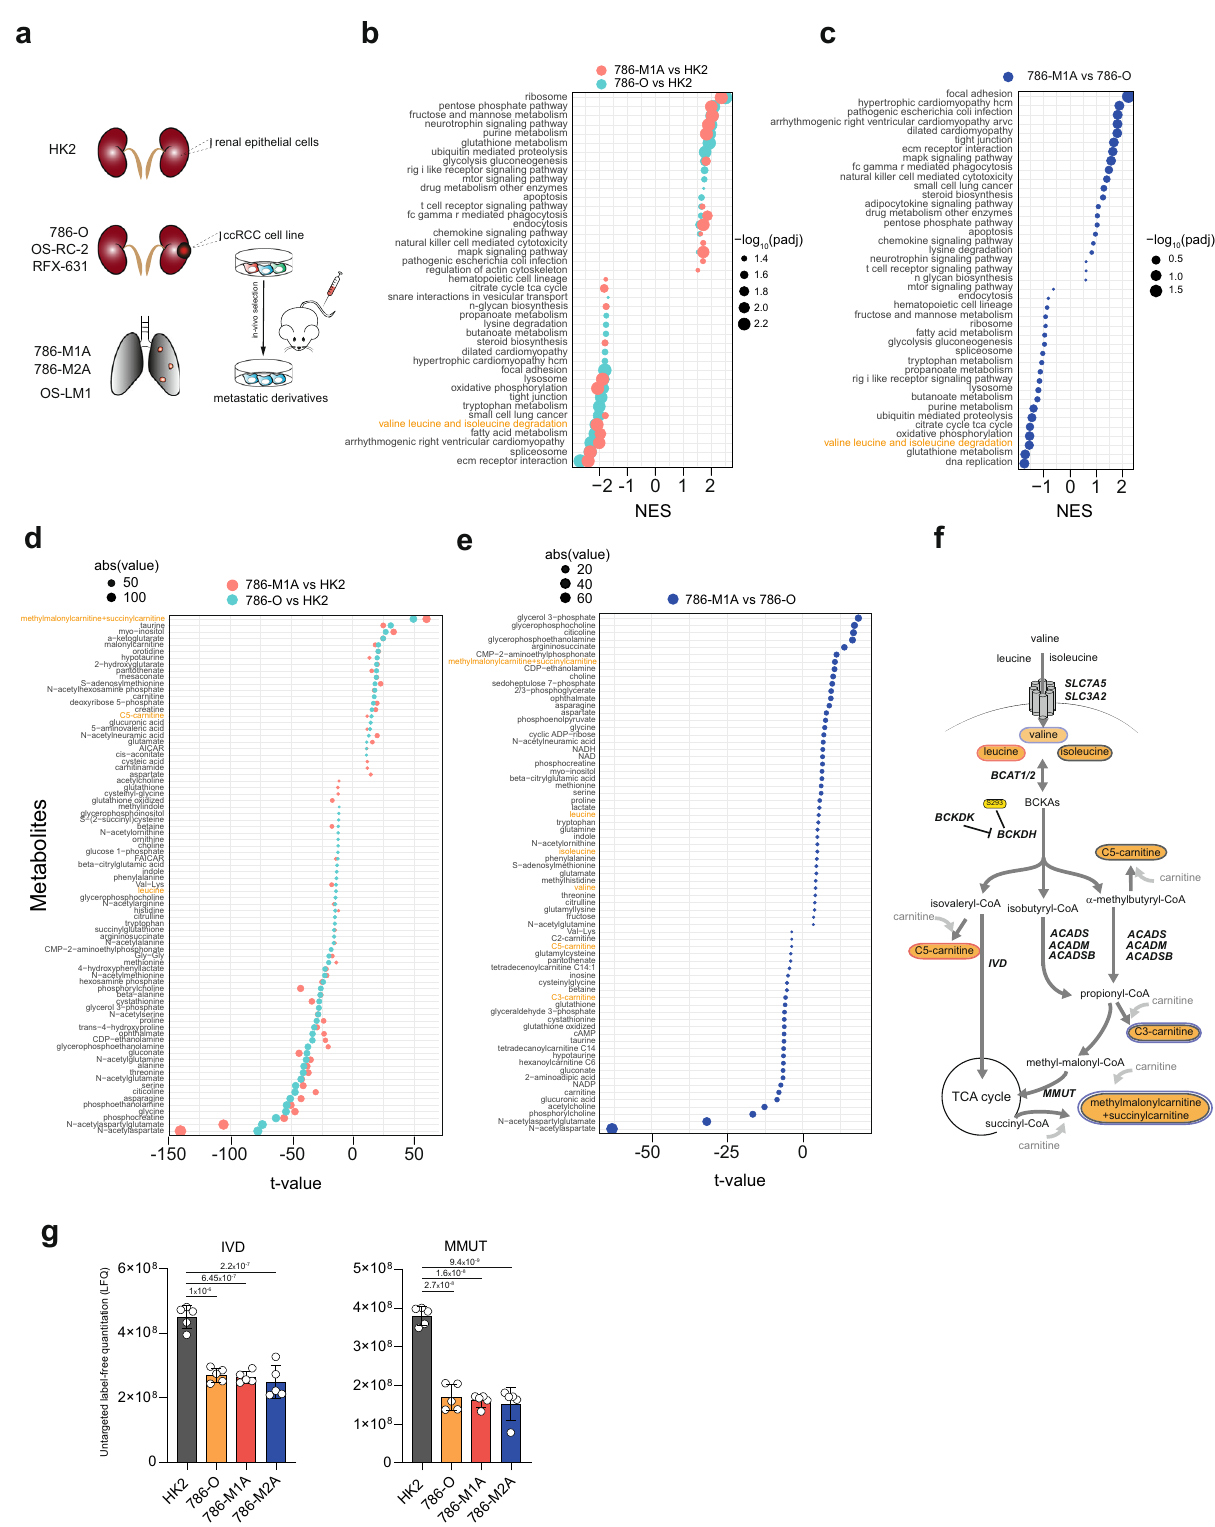
Fig.2a)inthepresence of 13 C 6